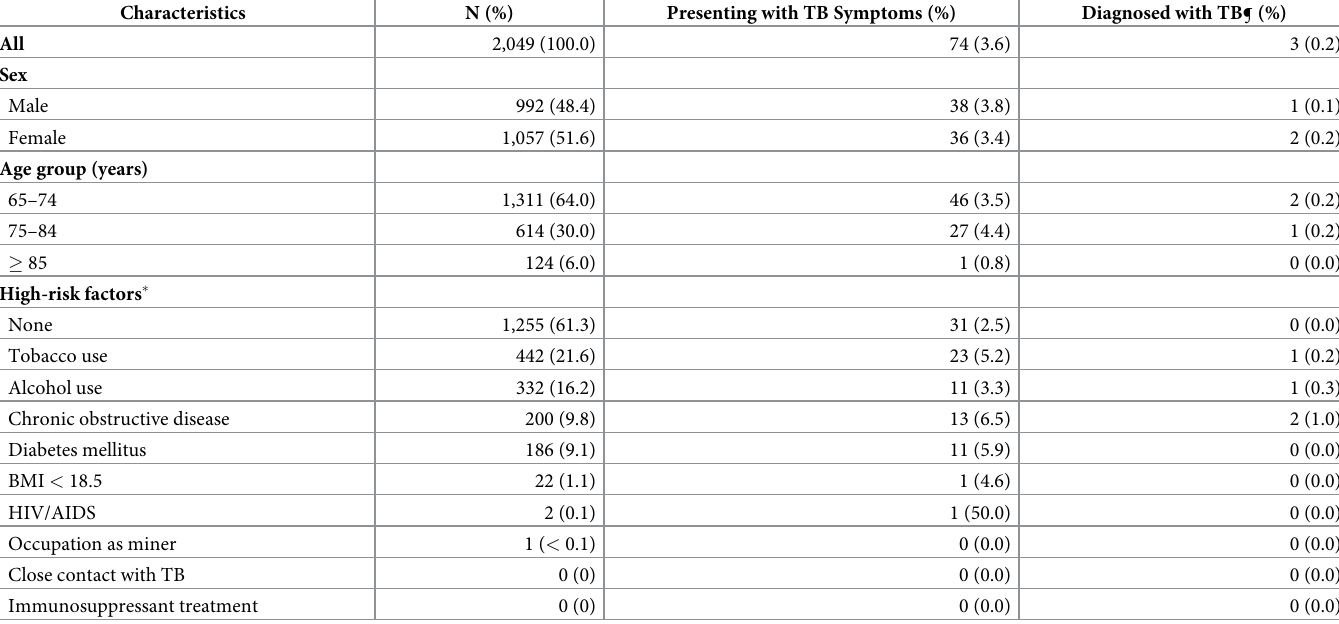
Table 2. Demographic characteristics and risk factors of seniors aged � 65 years participating in the active case finding project by TB symptoms and diagnosis, Bayi township, Sichuan Province, China, March–June